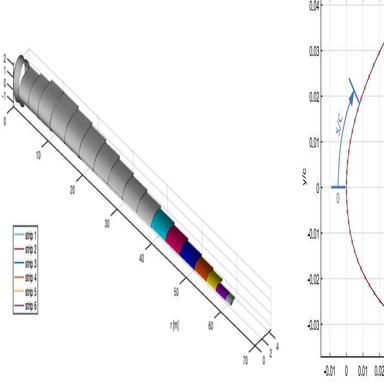
WT blade geometry and strip subdivision, definition of curvilinear coordinate ∕, airfoil geometry of six outermost strips.